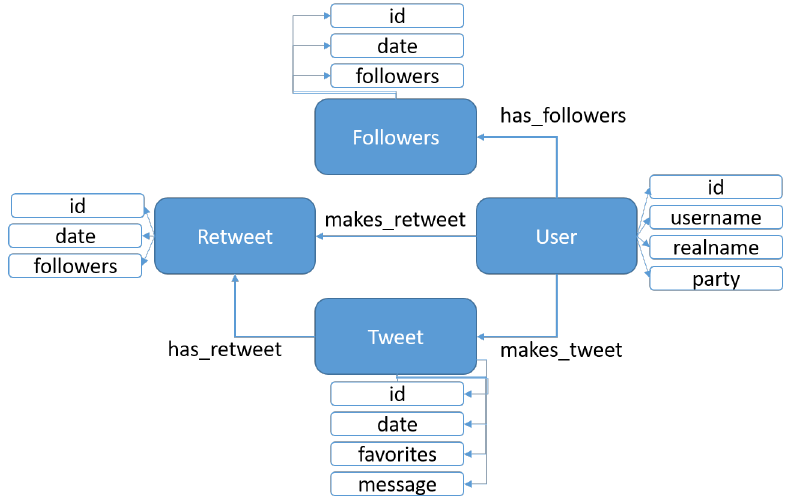
Figure 2. The entity relationship model of the generated